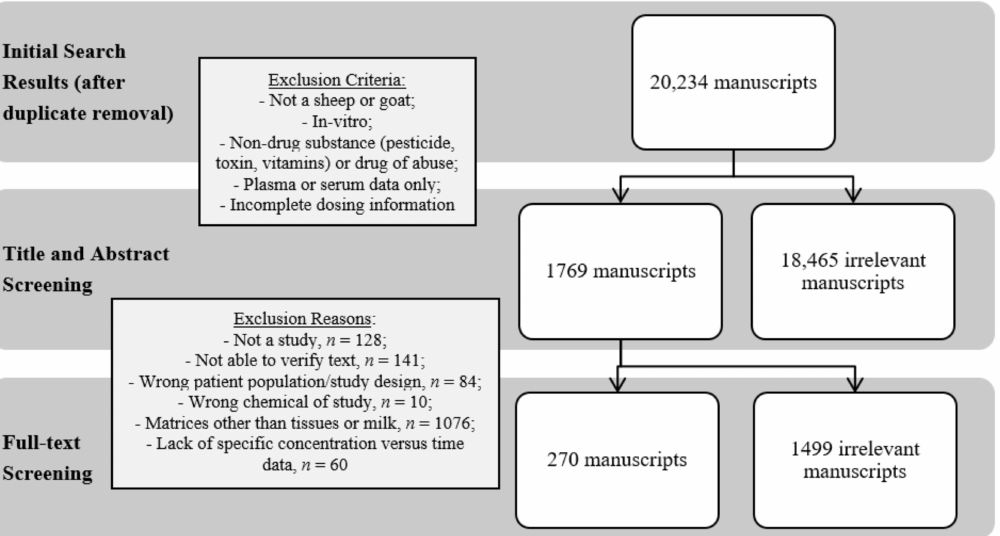
Figure 1. Schematic diagram of the process for three independent evaluators to assess published manuscripts and the numerical outcome of each step. The ultimate goal was to curate manuscripts with tissue and milk residue data from live sheep and goat antibacterial drug